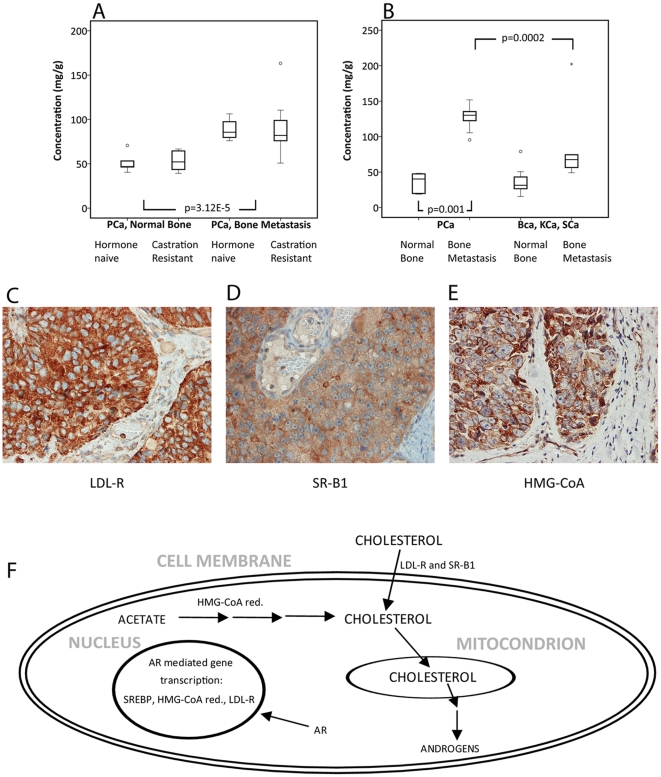
Cholesterol levels and expression of enzymes for cholesterol influx and synthesis.
A. Box plot for cholesterol concentration (mg cholesterol/g tissue) showing significantly higher levels in prostate cancer (PCa) bone metastases compared to normal bone. B. Box plot for cholesterol concentration (mg cholesterol/g tissue) in test set showing significantly higher levels in PCa bone metastases compared to normal bone as well as compared to bone metastases from other cancers; breast, kidney, and squamous cancer (BCa, KCa and SCa). C–E. Immunohistochemical staining of the low density lipoprotein receptor (LDL-R), the scavenger receptor class B type 1 (SR-B1), and the 3-hydroxy-3-methylglutaryl-coenzyme A reductase (HMG-CoA red.) in PCa bone metastases showing intense staining and indicating possibilities for influx as well as de novo synthesis of cholesterol in tumor epithelial cells, as suggested in F. F. Cholesterol influx and synthesis is stimulated by androgen receptor (AR) action partly via activation of the sterol regulatory element-binding protein (SREBP) and subsequent transcription of LDL-R and HMG-CoA red [24], [25] and androgens could be provided from cholesterol by its conversion in several steps [27], [28].